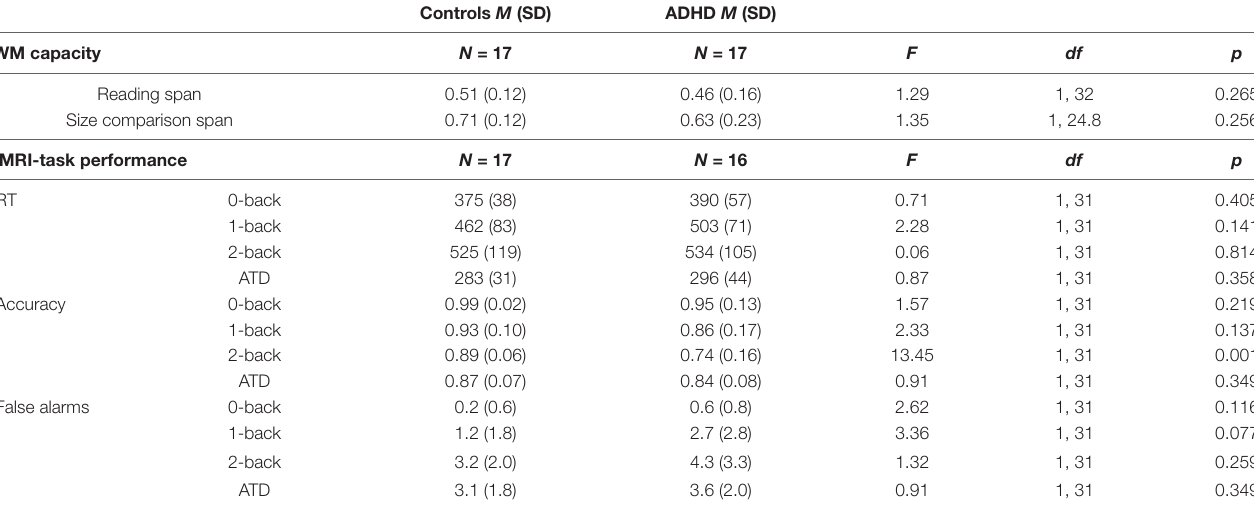
TABLE 2 | Descriptives and one-way ANOVA results (Welch test was applied when the assumption of homogeneity was violated) for group comparisons of working memory (WM) capacity and in-scanner task performance on the n -back and auditory target detection (ATD) conditions. RT: response times in milliseconds and correspond to accurate trials only. Due to a technical error, fMRI-task performance data was missing for one ADHD